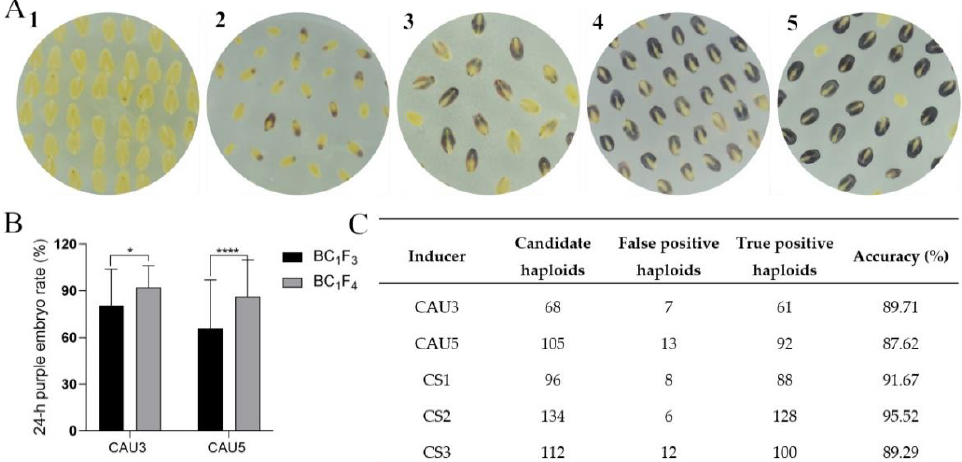
Figure 4. ( A ) Classifying the color of immature embryos. ( B ) Comparison of the 24-h purple embryo rate of crossing embryos between BC 1 F 3 and BC 1 F 4 . * p < 0.05, **** p < 0.0001. ( C ) Efficiency of identifying haploid immature embryos.